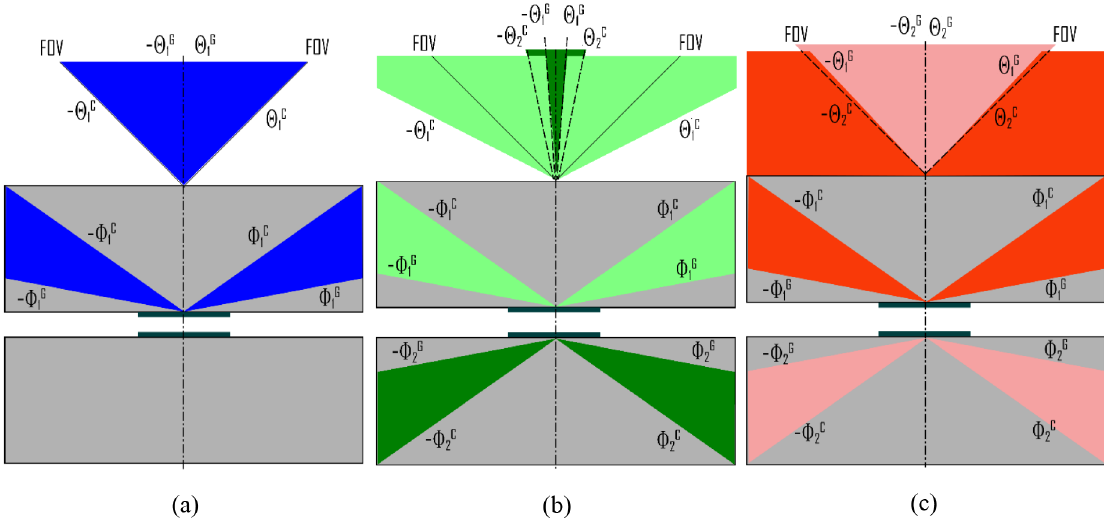
Fig. 3. Schematics of a single waveguide system with dual-mode embedded metagrating solution illustrating angles of incident and diffracted light for re fl ective and transmissive diffraction gratings for three different colors: (a) blue, (b) green, (c) red. Angles denoted using u are located in the air. Angles denoted using Φ are located in the waveguides and measure the angle of rays that have been diffracted. Superscript C indicates a critical ray (just at the TIR limit in the waveguide), either in air or in the waveguide. Superscript G indicates a grazing ray (the highest allowed angle of incidence in the waveguide).